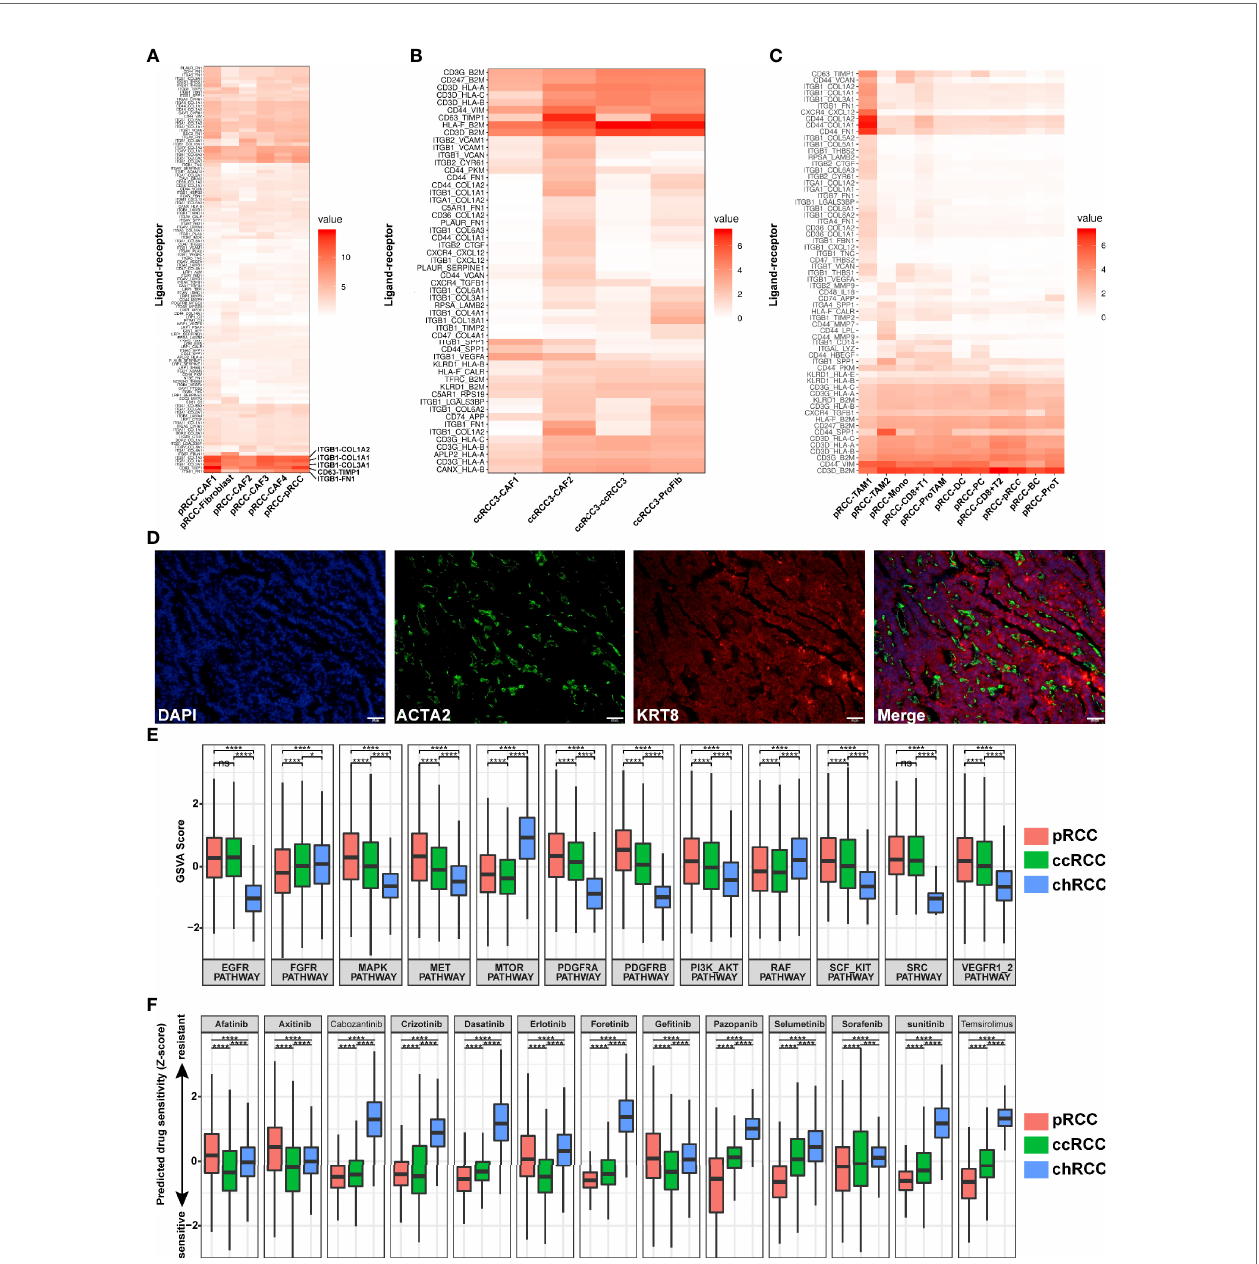
FIGURE 9 | Ligand – receptor interactions in RCC, prediction of drug target pathways and sensitivity to drug responses. (A) Ligand – receptor interactions in type 2 pRCC and CAFs. (B) Ligand – receptor interactions in ccRCC and CAFs. (C) Ligand – receptor interactions in type 2 pRCC and immune cells. (D) Spatial CAF location veri fi ed in type 2 pRCC using the CAF marker ACTA2 (green), epithelial cell marker KRT8 (red) and DNA staining via DAPI (blue) within the tissue paraf fi n sections from human type 2 pRCC samples. Scale bars, 50 m m. (E) Prediction of activation of drug target pathways. (F) Prediction of activation of drug sensitivity to drug responses. *p < 0.05, ***p < 0.01 and ****p <